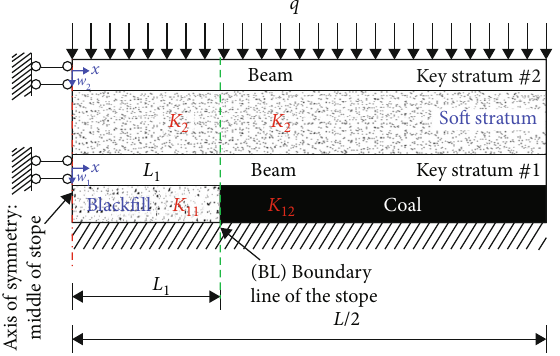
Figure 4: Double-layer Winkler foundation beam